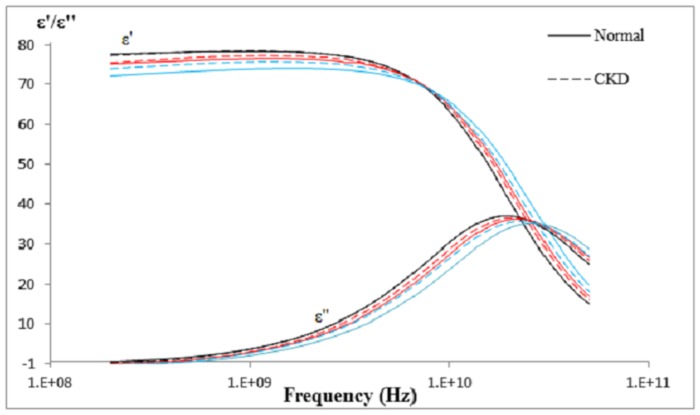
Variation of measured dielectric properties.Mean of measured dielectric properties in terms of dielectric constant and loss factor from normal (solid line) and CKD (dotted line) subjects at respective temperatures of 25°C (black), 30°C (red) and 37°C (blue), and with logarithmic scale of frequency ranging from 0.2 to 50 GHz, were plotted.